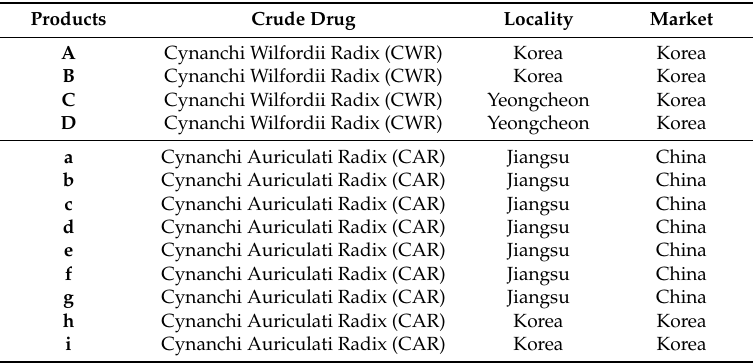
Figure 4. Crude drugs identified: ( A ) Cynanchi Wilfordii Radix (CWR, the root of Cynanchum wilfordii Hemsley) (Product C), and ( a ) Cynanchi Auriculati Radix (CAR, the root of Cynanchum auriculatum Royke ex Wight) (Product h). Table 2. The Korean and Chinese market samples used in this study.